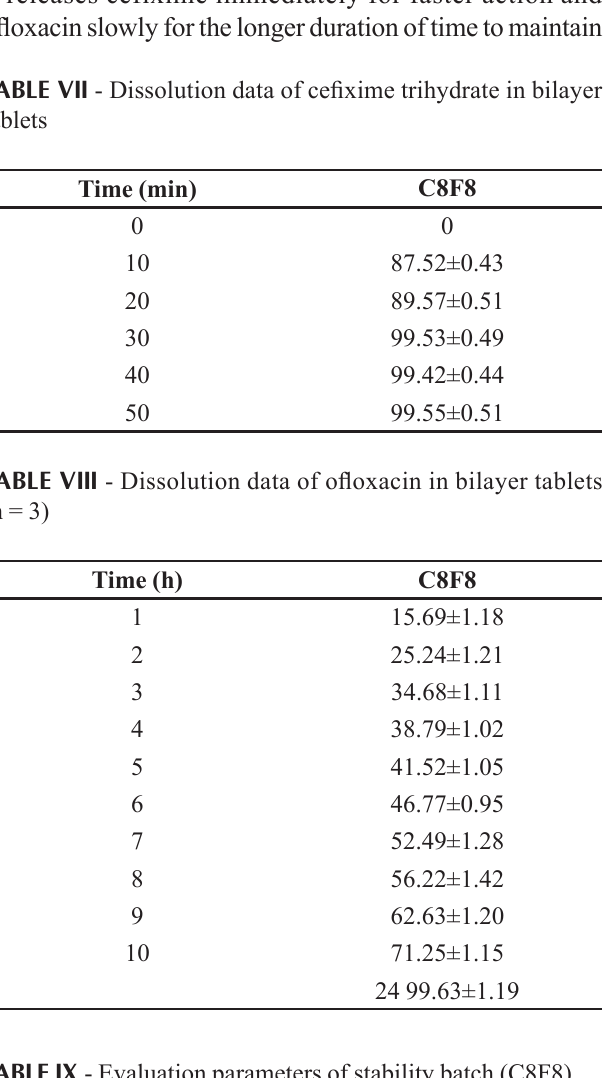
TABLE IX - Evaluation parameters of stability batch (C8F8) Evaluation